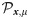
Intuition behind the proof of Theorem 4.As μ is increased, the polytope Px,μ cuts through the ribosome allocation constraint |α|=∑i=1n+1αi≤λ, with |α| = λ shown in blue. Exactly at the maximal growth rate, the intersection of the polytope with |α| = λ is reduced to one vertex (black dot), i.e., one EGS.